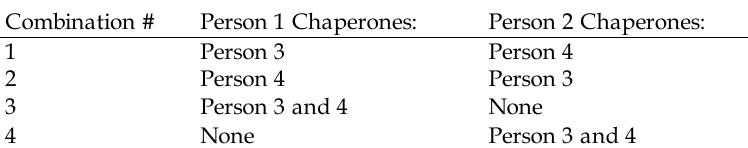
Table 3. Potential Chaperone-Dependent